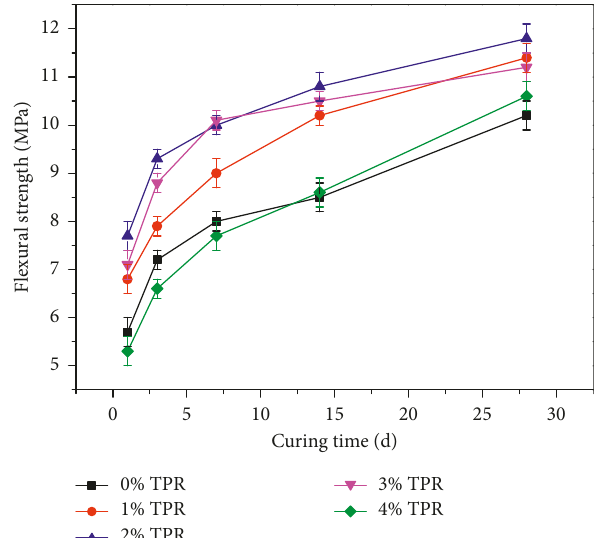
Figure 9: Flexural strength of cement stone with different TPR contents for different curing